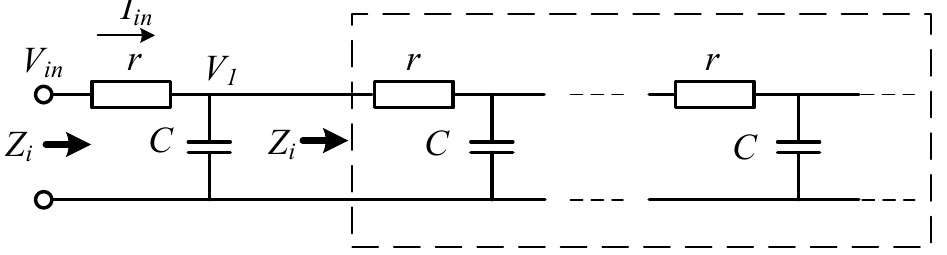
Figure 5. Infinite r–C chains based equivalent circuit of a capacitor (r: resistor, C: capacitor, Zi: input impedance, 𝑉 (cid:3036)(cid:3041) : input voltage, 𝐼 (cid:3036)(cid:3041) : input current).